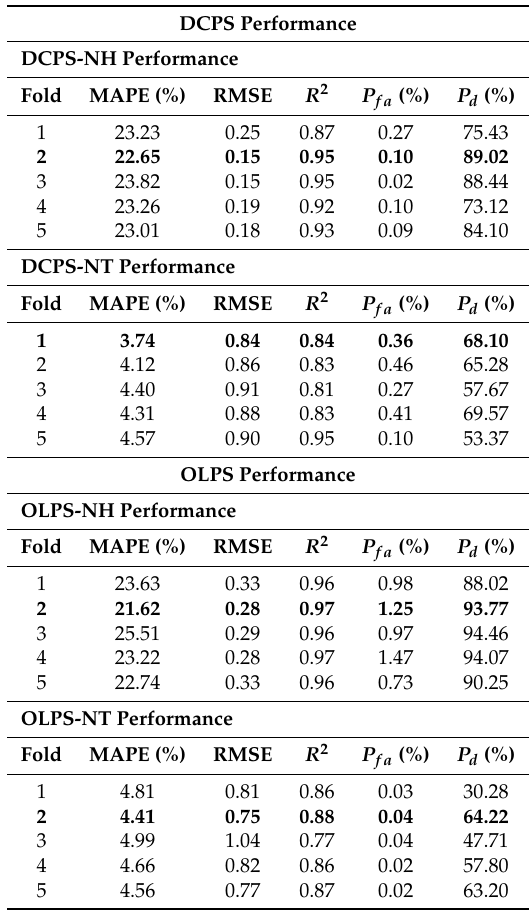
Table 6. Performance of DCPS and OLPS structures after applying the K-Fold technique. Results in bold correspond to the fold that offers the best performance in terms of the MAPE and